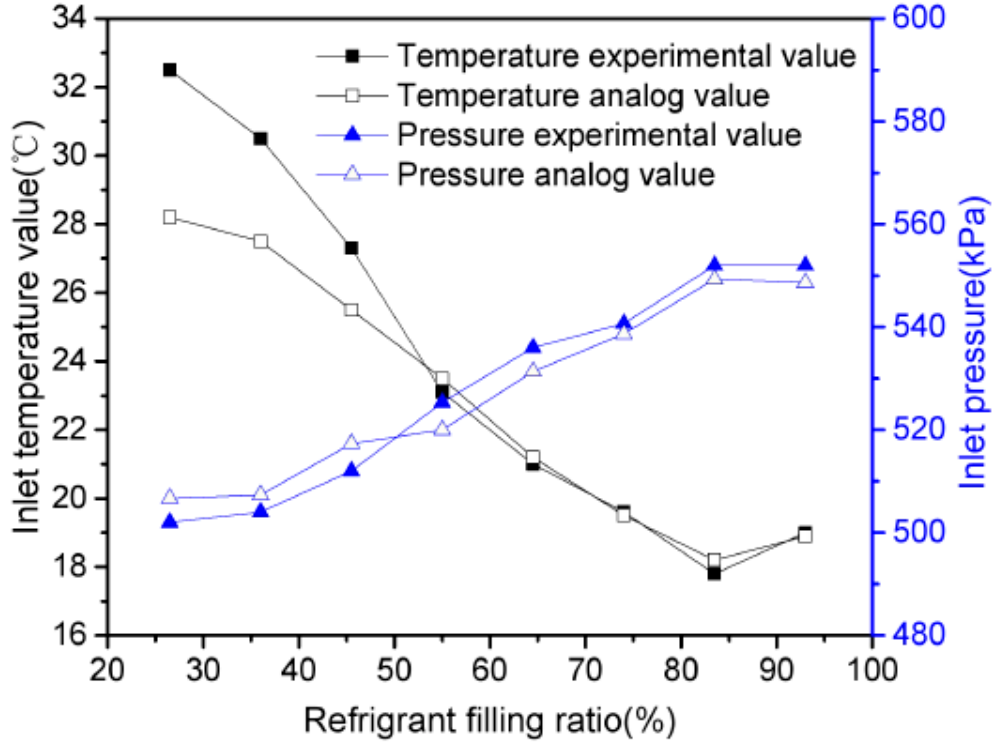
Figure 9. Temperature and pressure comparison of cooling distribution unit (CDU) inlet